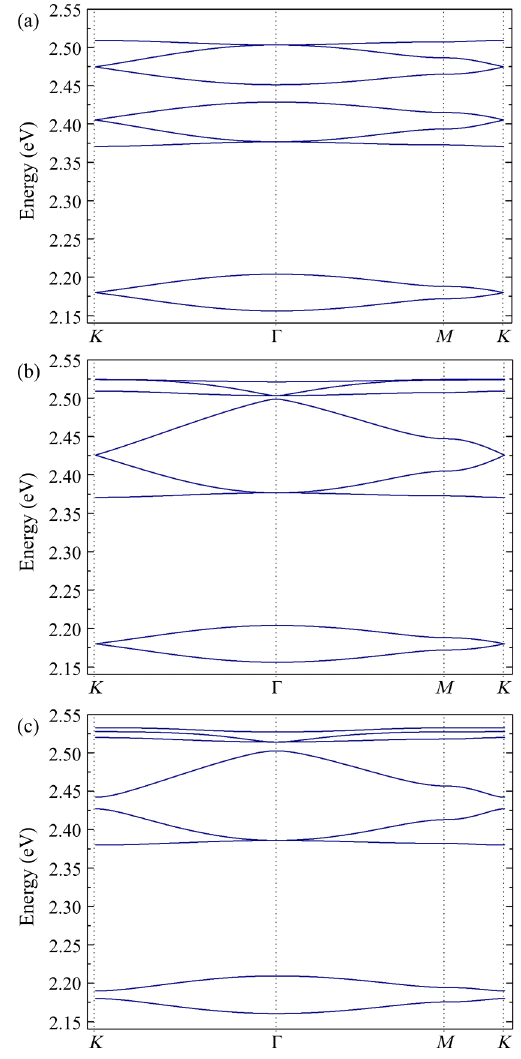
FIG. 10 (color online). Band structure calculated for a silicene- type lattice using the effective tight-binding Hamiltonian for A; B Þ ¼ 2 . 18 eV, and all three sets of parameters. (a) E s ð